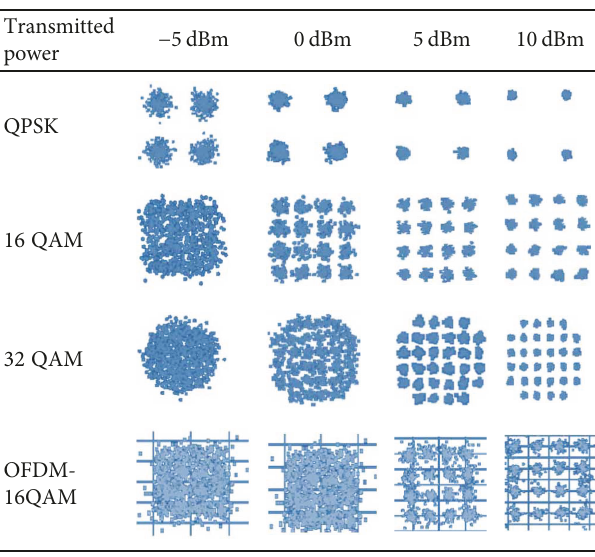
Table 5: Received constellations for various modulation schemes and transmitted power